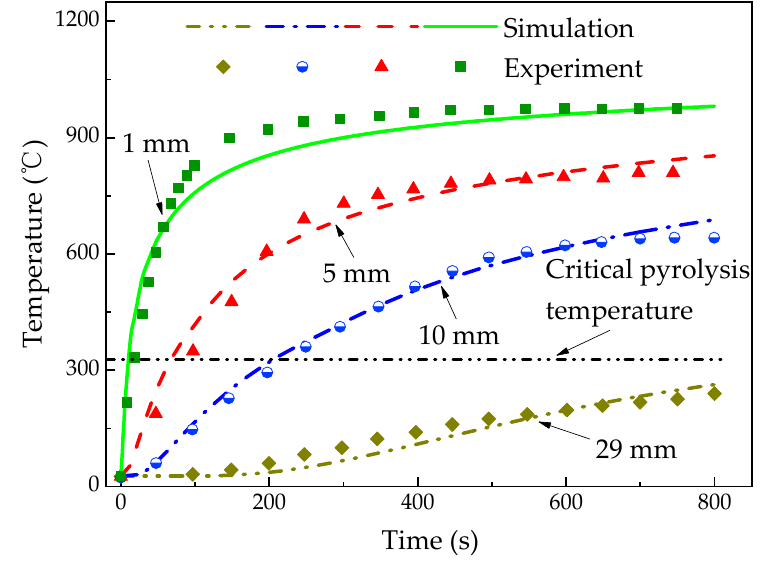
Figure 4. Temperature profiles of the glass fiber/phenolic resin composites under one-sided heating.